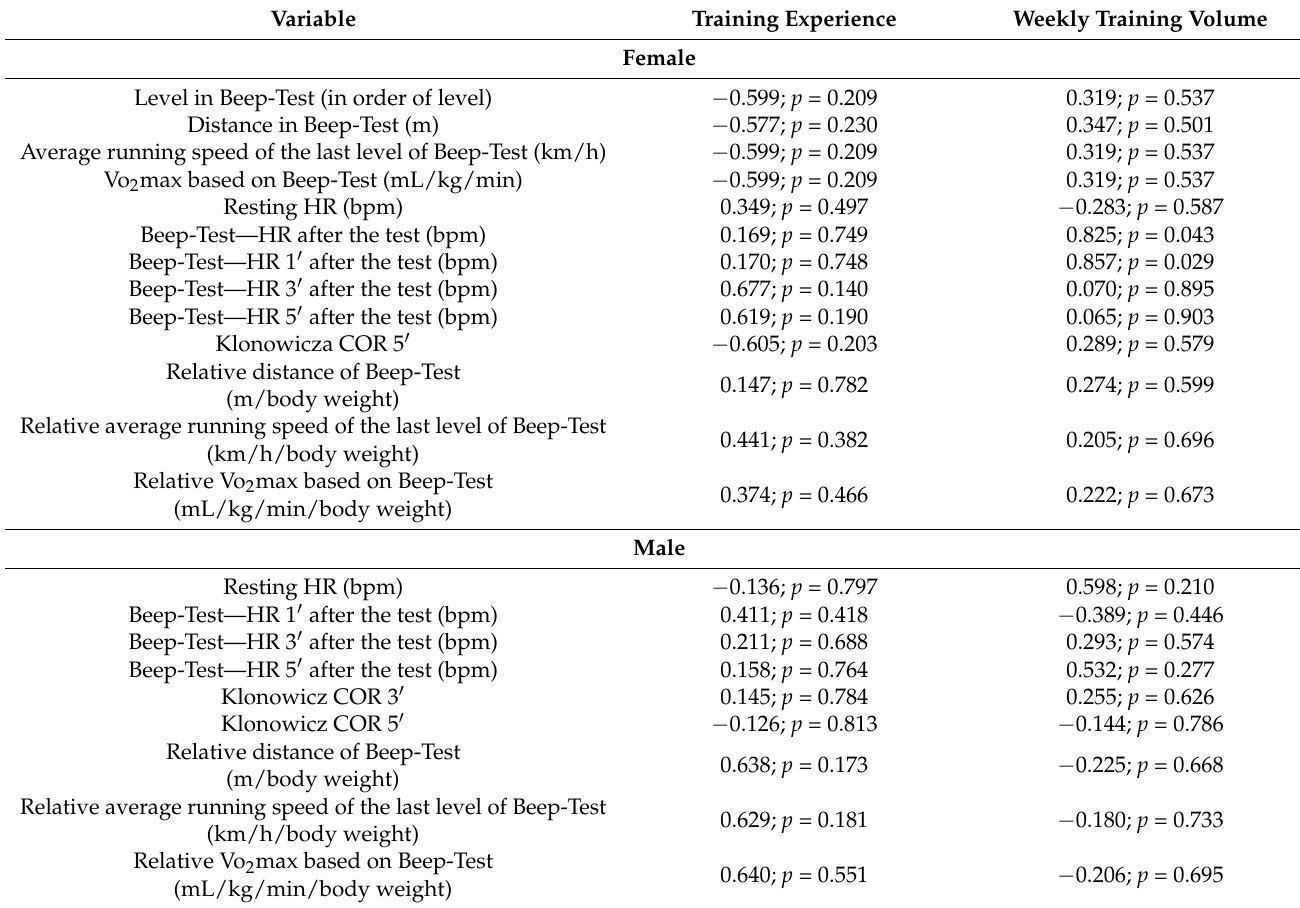
Table 2. Training experience and weekly training volumes versus Beep-Test scores and COR of female and male judo cadet (U18) national team athletes using Pearson’s r correlation (for variables not significantly deviating from the normal